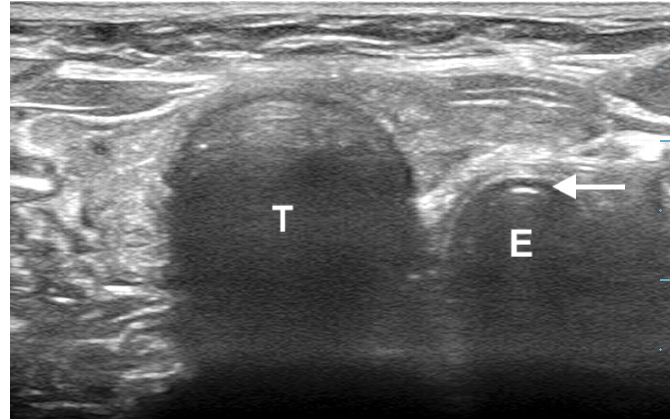
Figure 1. Endotracheal intubation using the static technique to confirm placement. T , trachea; white arrow, endotracheal tube.